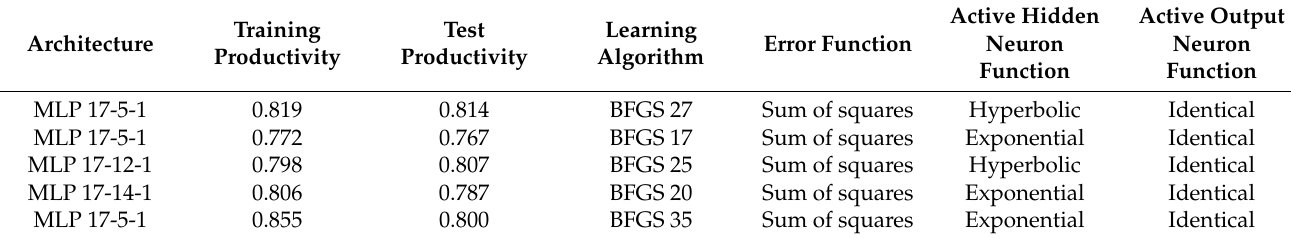
Table 3. Architectures and results of neural